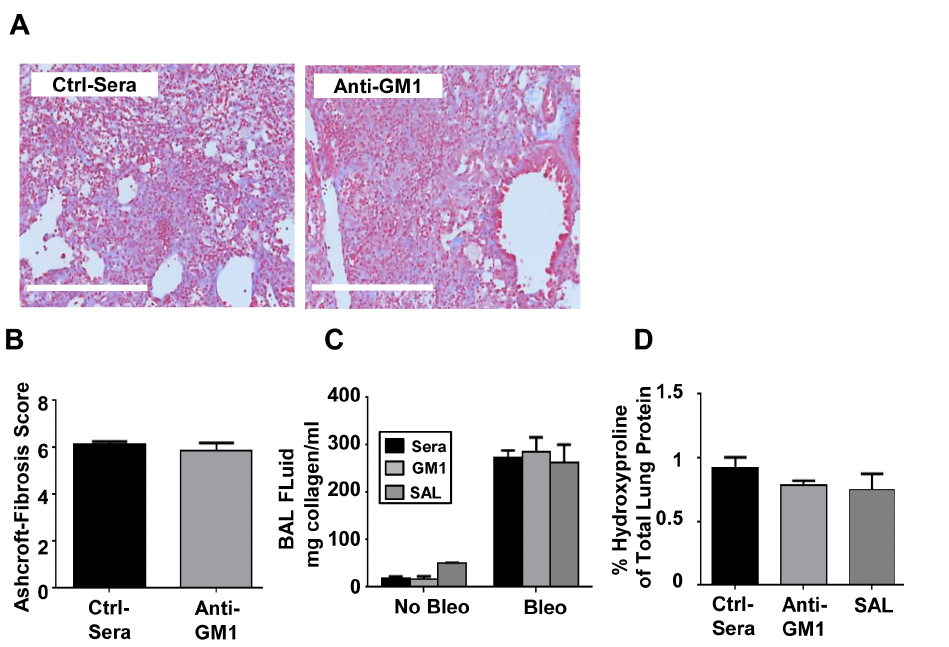
Figure 5. Anti-asialo GM1 treatment does not alter development of BIPF. ( A ) On day 21 after bleomycin treatment, lungs from control sera or anti-asialo GM1 treated mice were isolated, embedded in formalin, sectioned and stained with Mason’s Trichrome for visualization of collagen deposition. Quantification of fibrosis score was performed using the Ashcroft scoring system. Mean 6 SEM of n=5 mice per group. ( B ) Soluble collagen levels in BAL fluid were measured by Sircol assay from mice treated with saline (SAL), control sera, or anti-asialo-GM1. ( C ) Lung collagen content was measured in lung homogenates on day 21 post bleomycin administration by hydroxyproline assay, and the amount of hydroyxproline was calculated as a percent of total lung protein. Mean 6 SEM of n=8–10 mice per